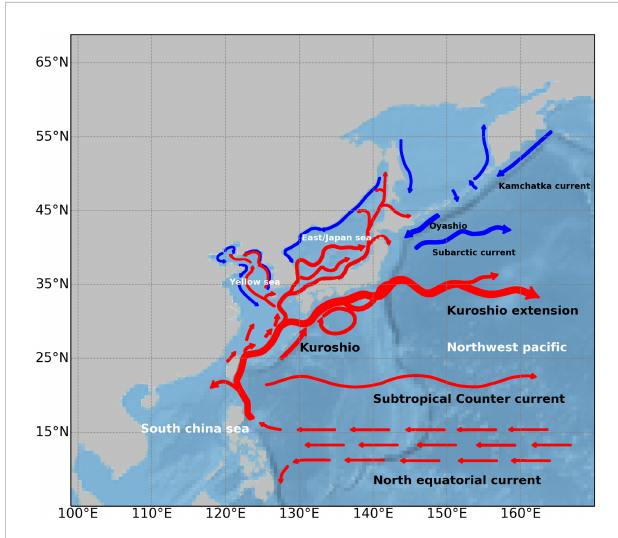
FIGURE 1 Ocean current map in Northwest paci fi c is from Park et al.